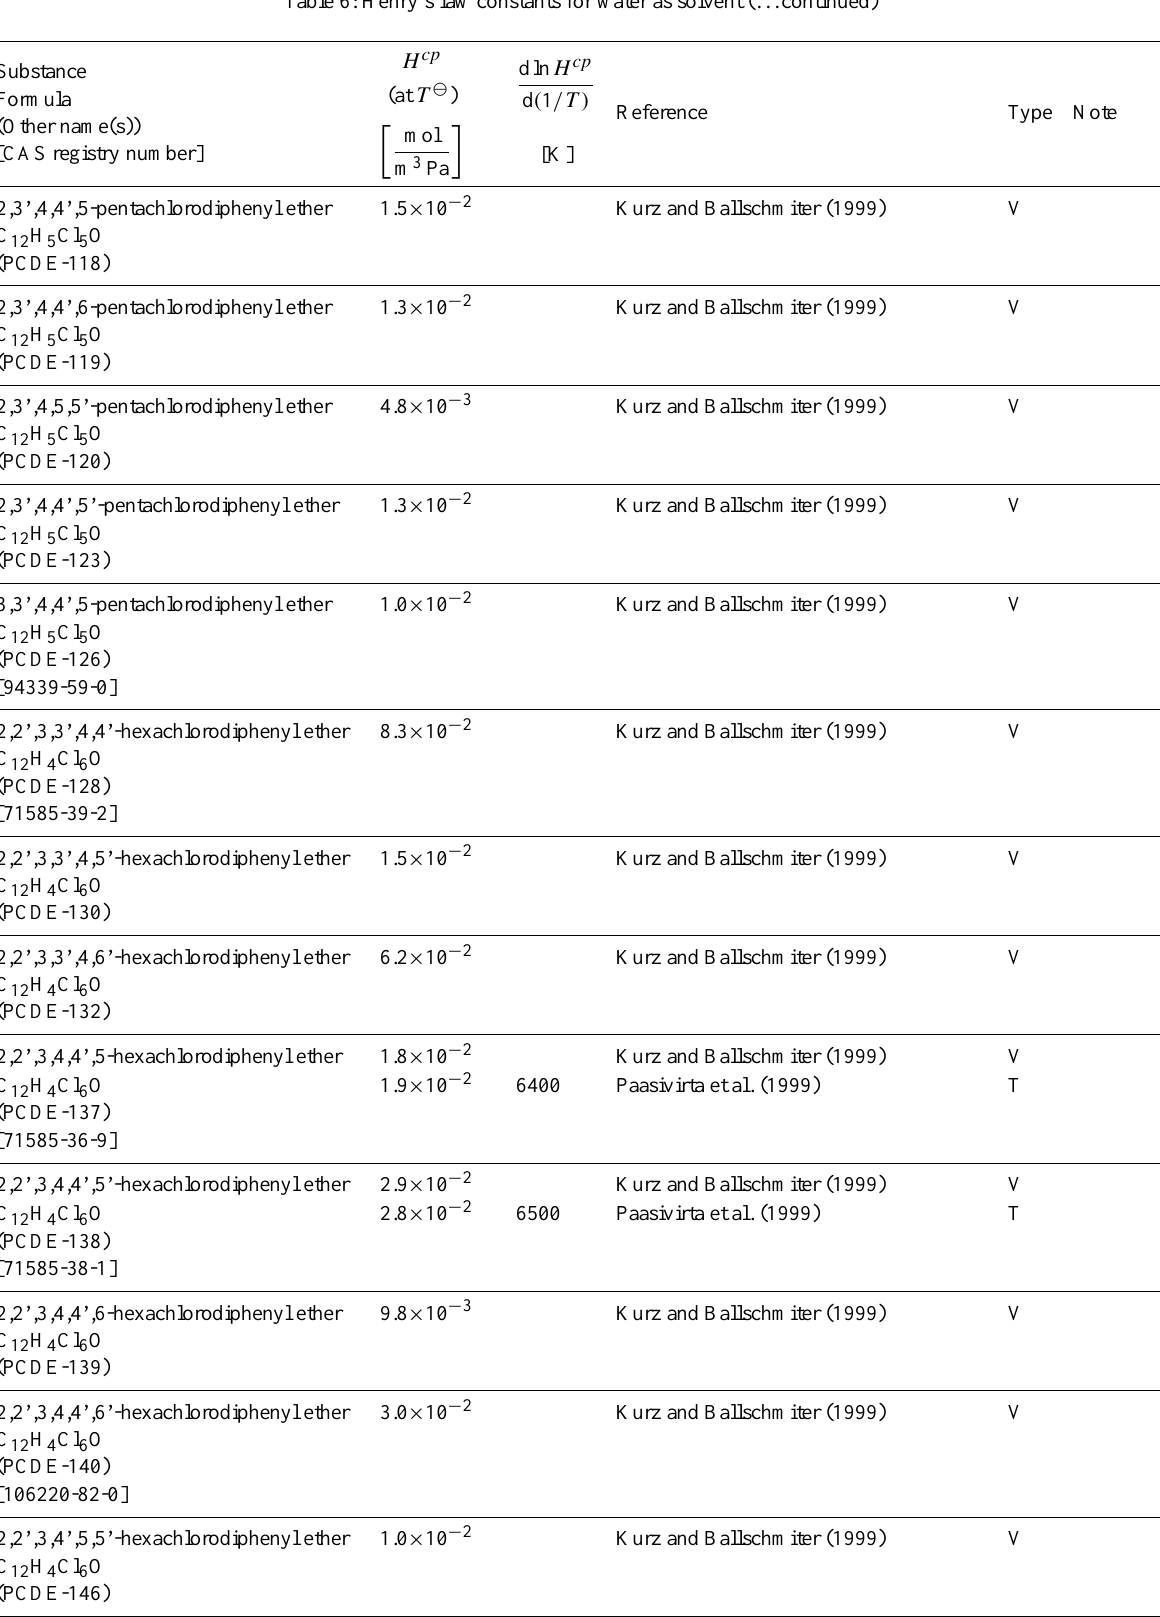
Table 6: Henry’s law constants for water as solvent